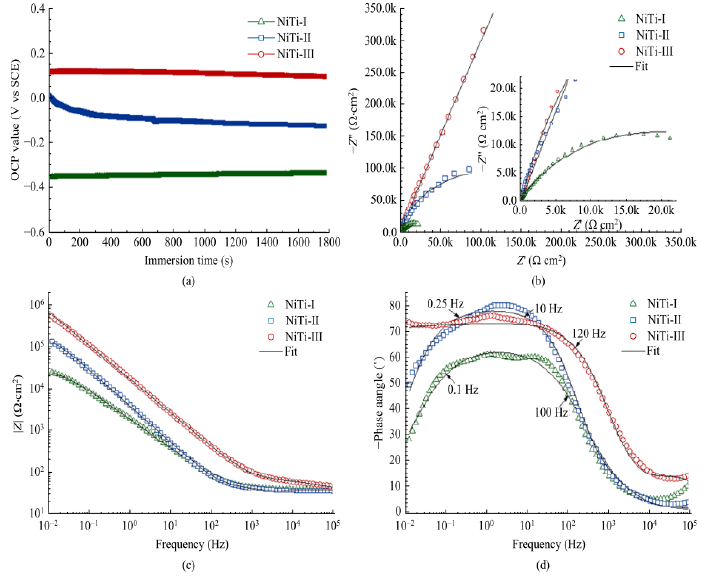
Figure 33. EIS results of NiTi − I, NiTi − II, and NiTi − III samples in SBF: ( a ) OCP curve, ( b ) Nyquist diagram and fitting curve, ( c ) Bode diagram and fitting curve of impedance modulus with frequency, and ( d ) Bode diagram and fitting curve of phase angle with frequency (Reprinted with permission from Ref. [63]. 2021, Yang, C.J.).